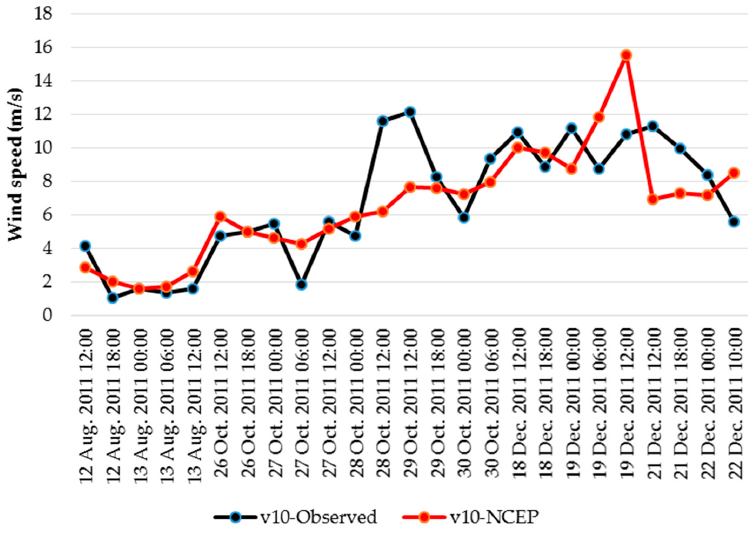
Figure 10. Comparison between observed and estimated (NCEP) wind speeds at 10 m height.